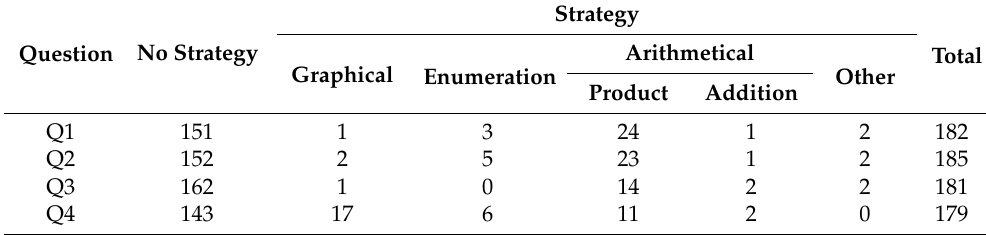
Table 2. Strategies frequencies in each problem.